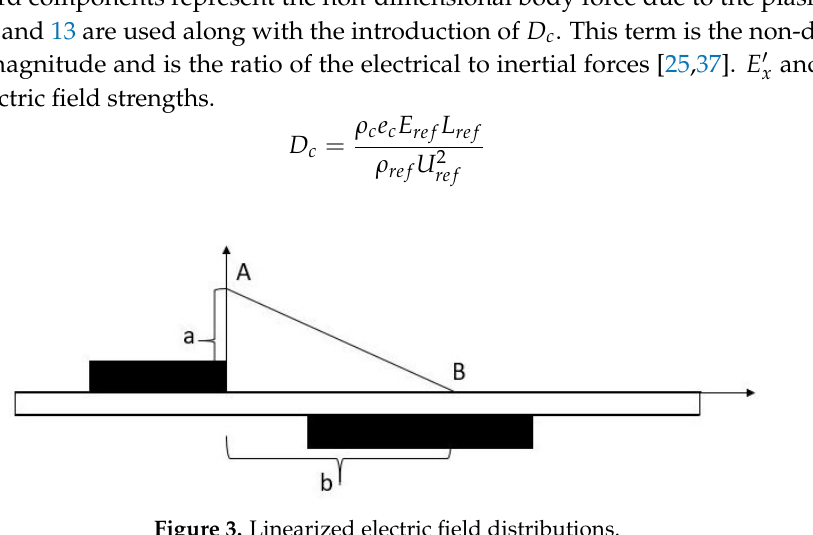
Figure 3. Linearized electric field